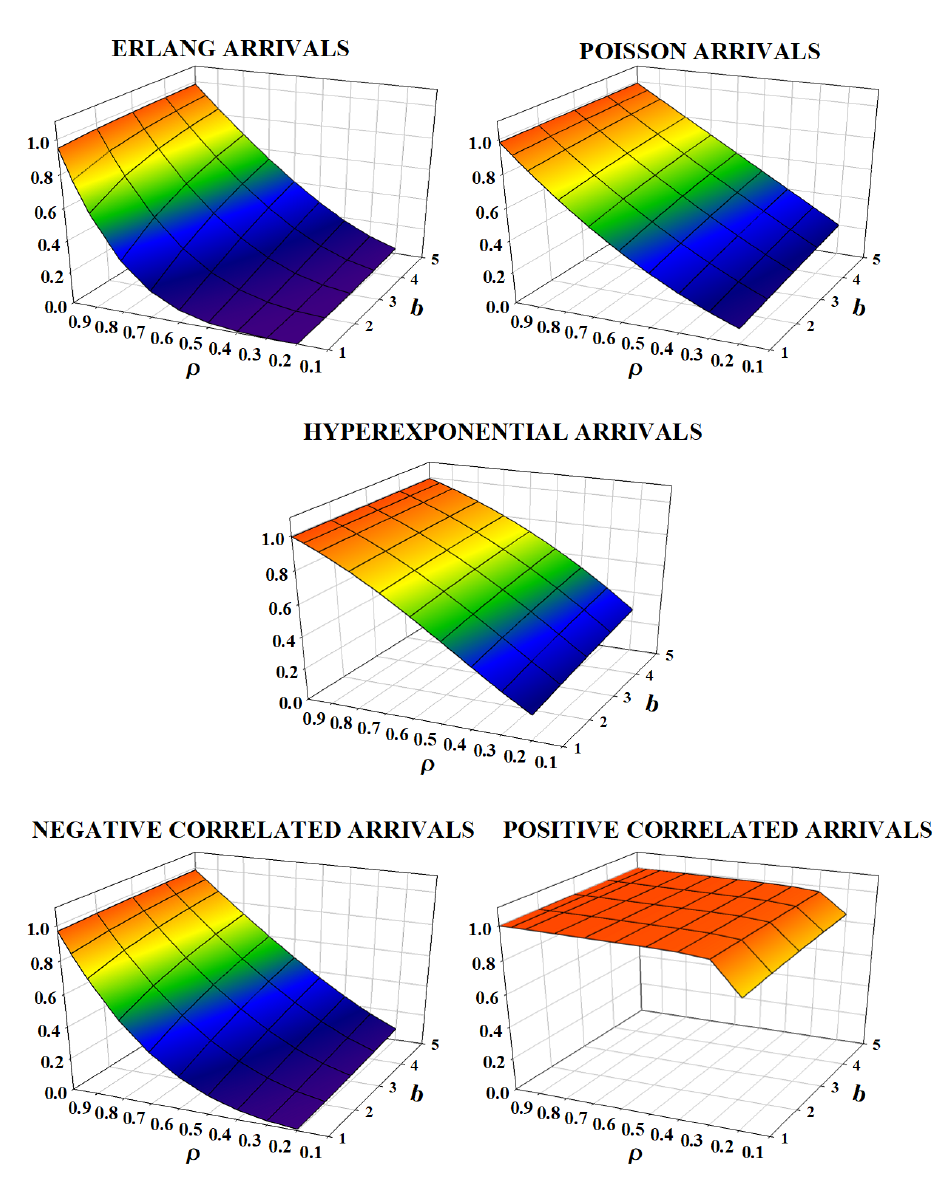
Figure 13. Spectral radius ( η ) for example